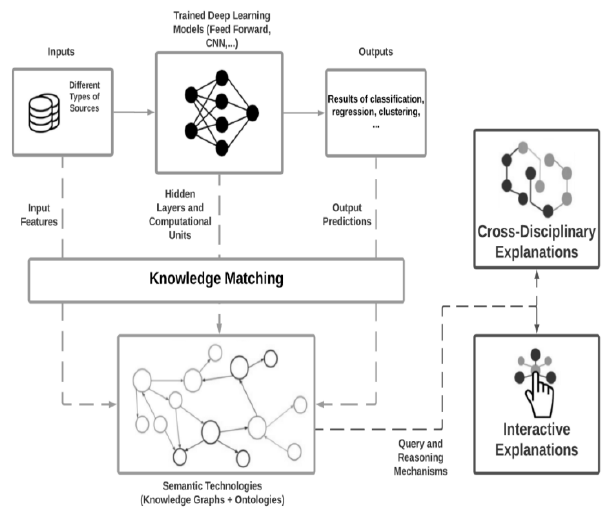
Figure 1. Block diagram – Knowledge representation graph using autoregression analytics method Density: Density function is used to measure trained deep learning results and knowledge matching results